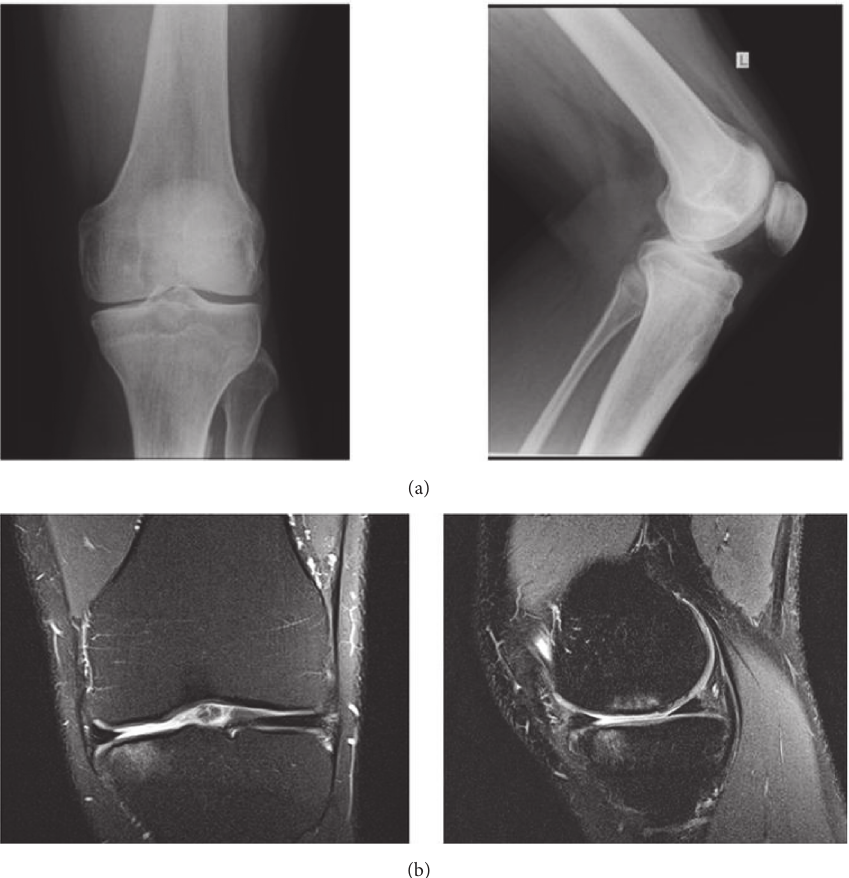
Figure 1: Presurgery anterior and medial radiographs (a) and coronal and sagittal MRIs (b) of the affected left